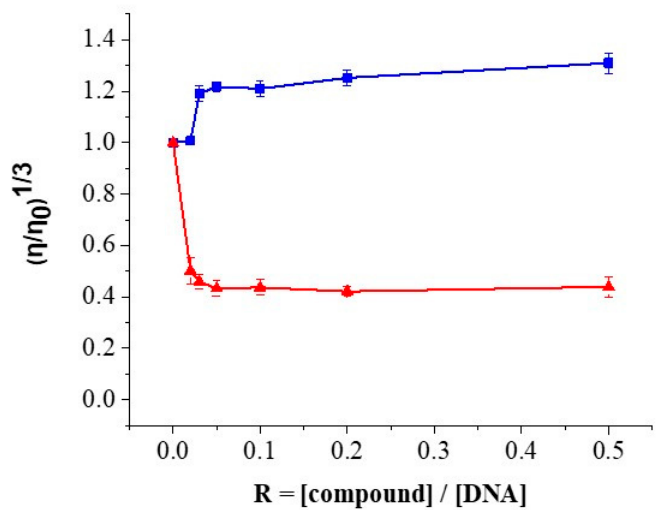
Figure 8. Effects of increasing amounts on the relative viscosity of CT-DNA (5 × 10 − 5 M) upon addition of Cu-1 (blue line) and L1 (red line) (0–2.5 × 10 − 5 M) with ratios R = [compound]/[DNA] ranging from 0 to